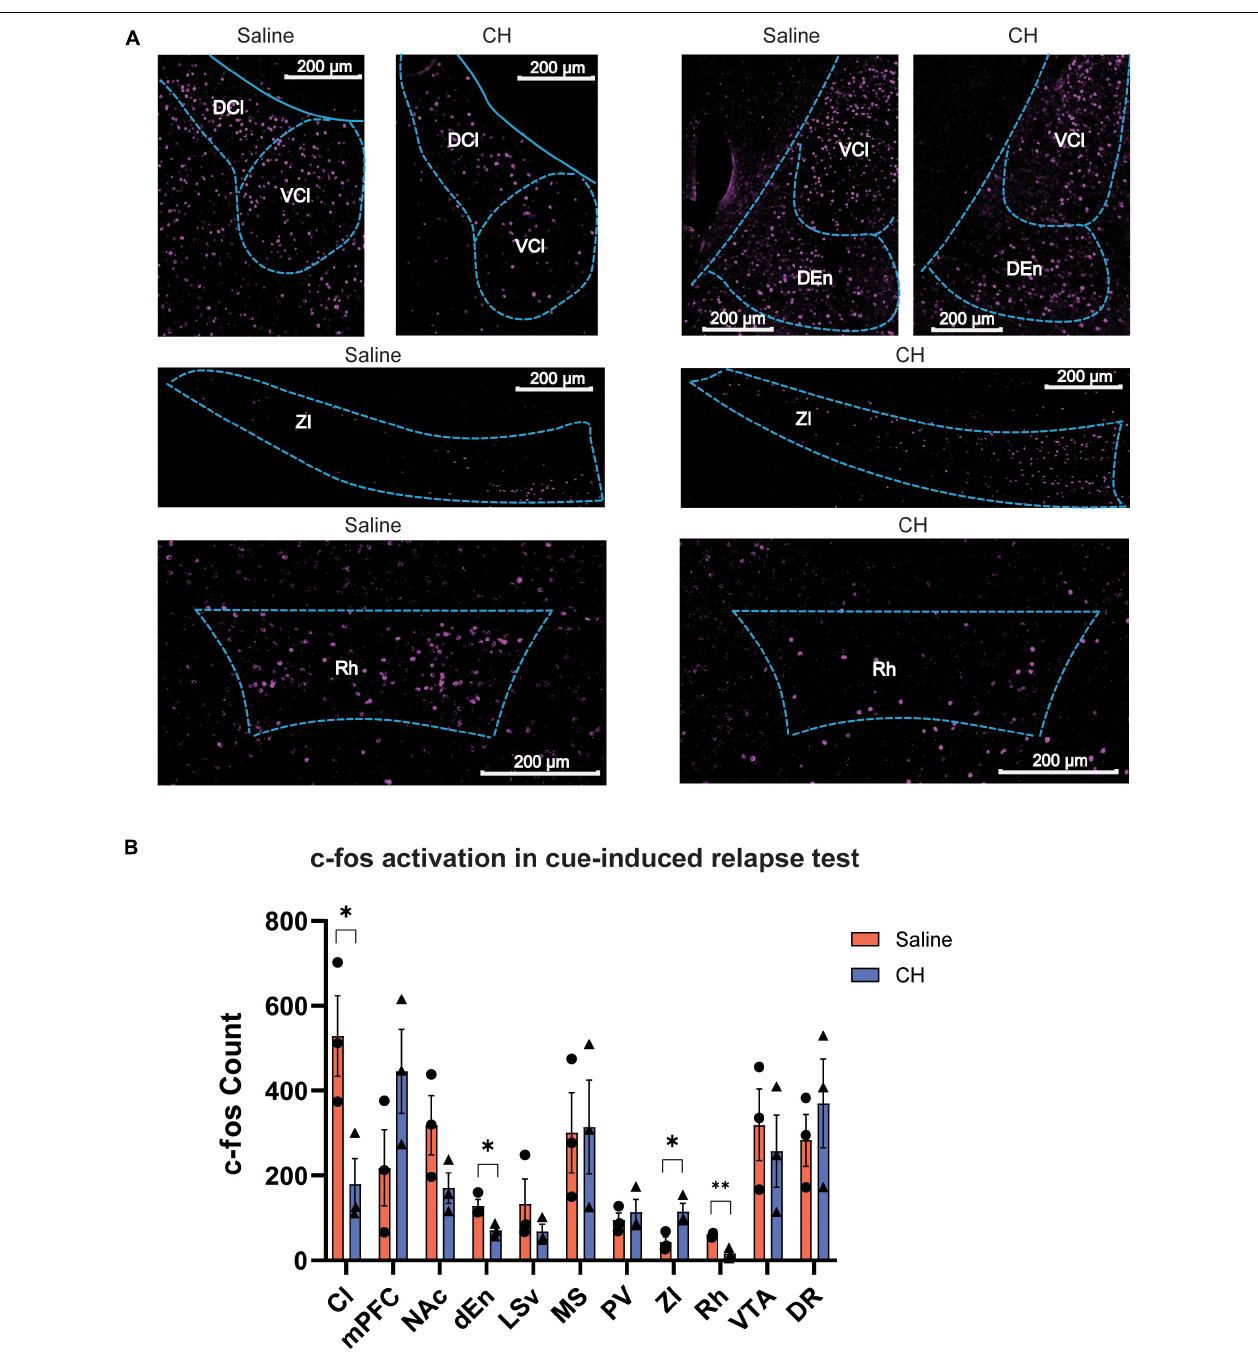
FIGURE 4 | C-fos brain activation after cue-induced Meth relapse in saline- and CH-treated groups. (A) Example images showing c-fos expression of multiple brain regions after relapse test ( N = 3 for both groups). (B) Quantification of brain regions with significant differences in c-fos expression between saline (red) and CH (blue) rats. p -values are presented in Supplementary Table 1 . Abbreviations: rhomboid thalamic nucleus (Rh), dorsal endopiriform nucleus (dEn), zona incerta (ZI), claustrum (Cl), medial prefrontal cortex (mPFC), nucleus accumbens (NAc), lateral septal nucleus, ventral part (LSv), dorsal raphe (DR), medial septal nucleus (MS), paraventricular thalamic nucleus (PV), and ventral tegmental area (VTA). Student’s t -tests. ∗ p < 0.05, ∗∗ p <